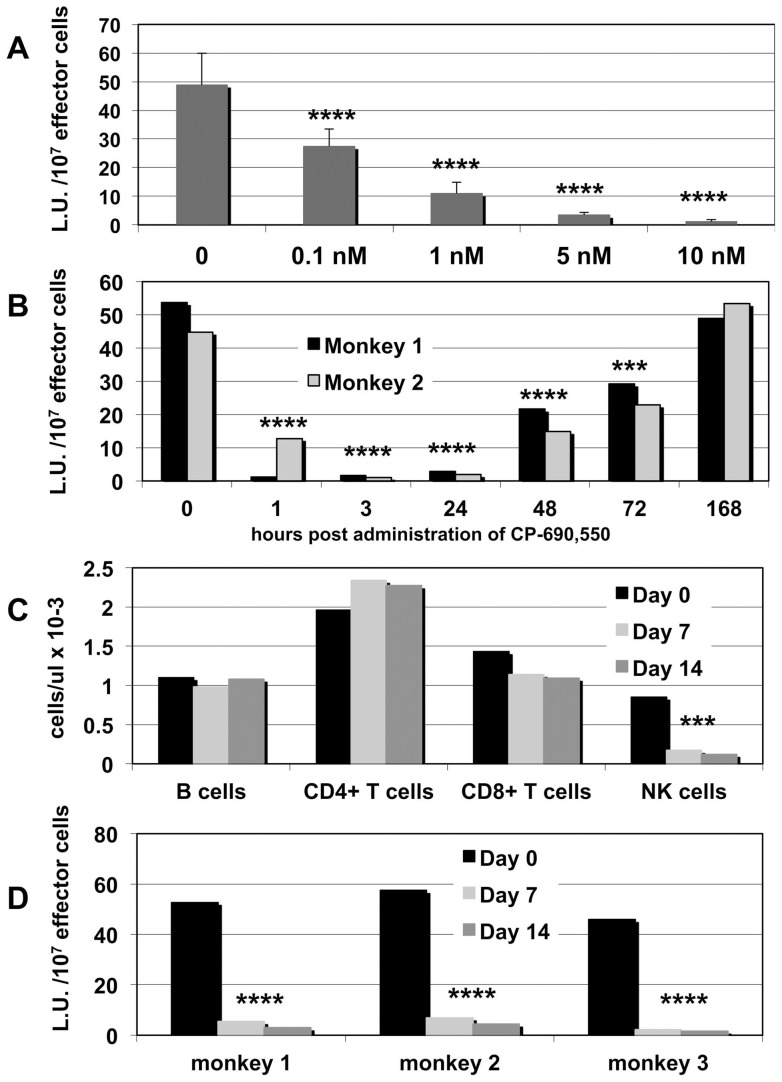
The effect of the JAK3 inhibitor on rhesus macaque NK cell function in vitro/ in vivo and on the frequencies of the major cell lineages in the blood.A) PBMC from 9 normal rhesus macaques was assayed for NK activity in the presence and absence of varying concentrations of the JAK-3 inhibitor. The mean lytic units/106 effector cells were calculated. The S.D. was always <10%. B) Two normal rhesus macaques were orally administered 10 mg/kg of the JAK3 inhibitor and PBMC samples obtained prior to and at 1, 3, 24, 48, 72 and 168 hrs. post JAK3 administration and assayed for NK activity. Results reflect Mean lytic units of NK activity/106 effector cells performed in triplicated with the S.D. <10%. C) Three normal rhesus macaques were orally administered the JAK3 inhibitor at 10 mg/kg daily for 14 days and an aliquot of their PBMC obtained prior to and at day 7 and 14 subjected to polychromatic flow cytometric analysis for the frequencies of CD4+ T cells, CD8+ T cells, CD20+ B cells and CD3−/CD8+/NKG2a+ cells. An aliquot was utilized for CBC and the absolute numbers of each cell lineage calculated and illustrated. Note the major depletion of the NK cells D). Another aliquot of the PBMC from C) were assayed for NK cell function and the data shows the Mean lytic units/106 effector cells. The S.D. was always <10%.